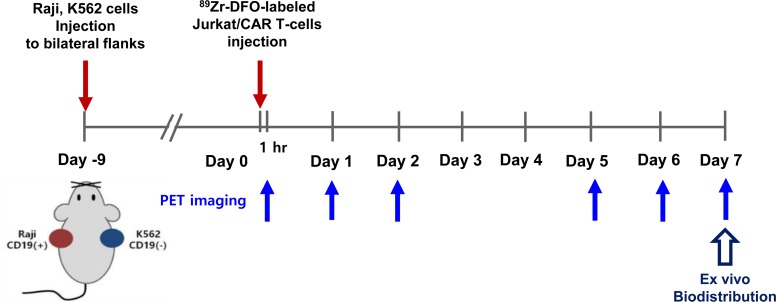
Animal study scheme.